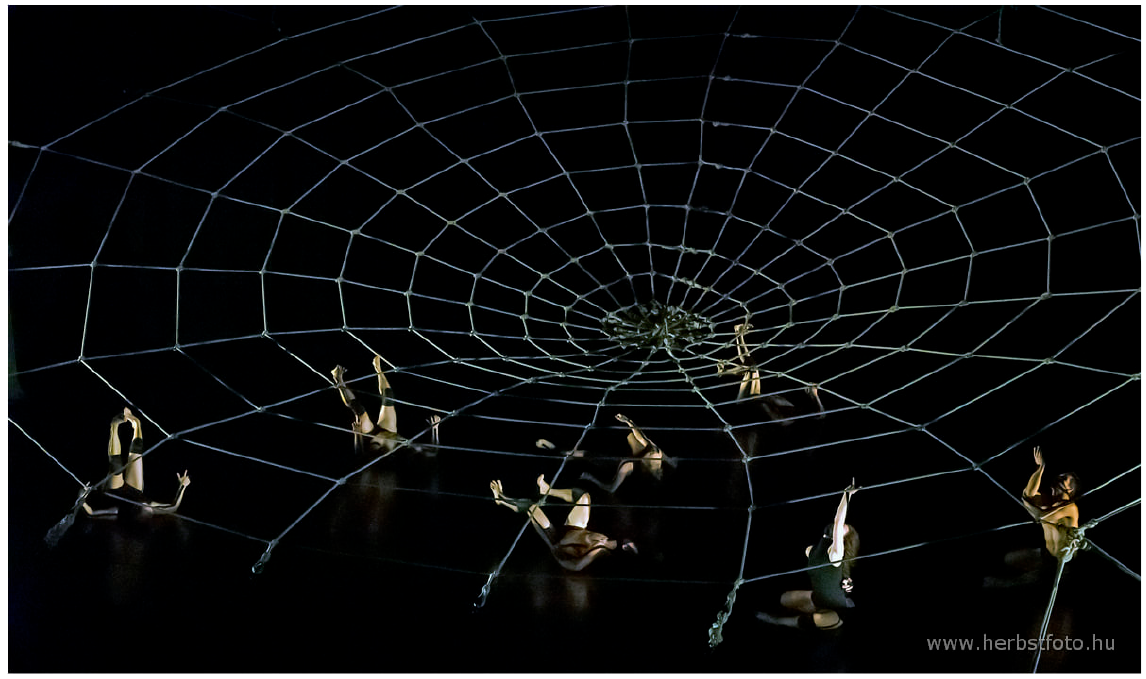
Figure 6. The gigantesque spider-web of Spid_er © Rudolf Herbst. 5. Struggling and fighting are very important features in Frenák’s movement language.